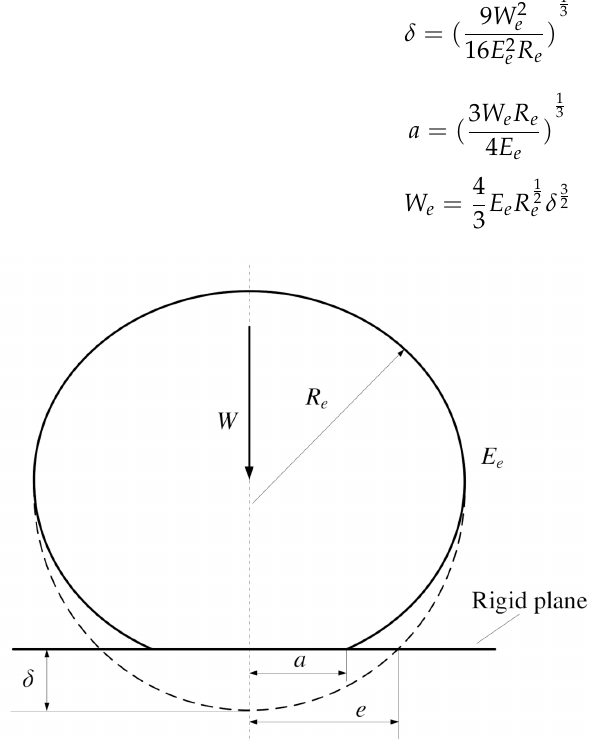
Figure A1. Schematic diagram of contact between elastic sphere plane and rigid